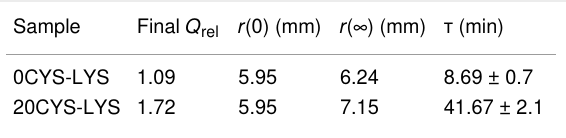
Table 2: Swelling kinetics data of the different gels.